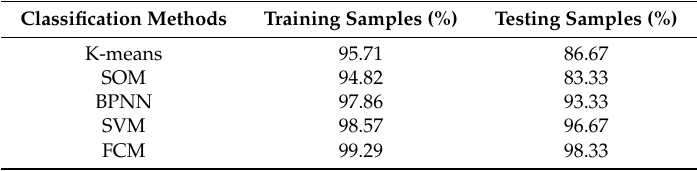
Table 3. Comparisons between the current work and some common